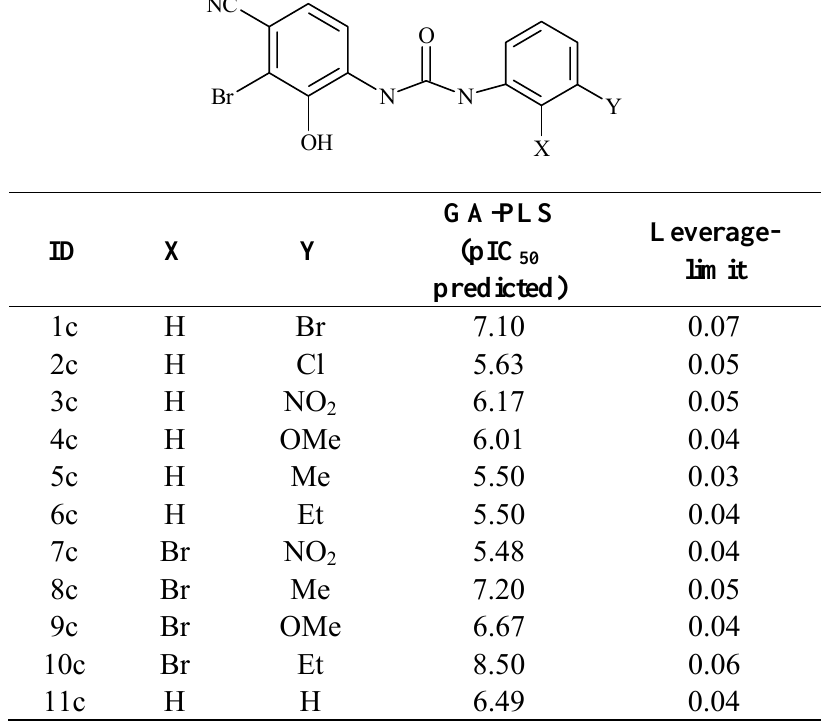
Table 15. Structural modification of CXCR2 receptor antagonists and predicted activities.